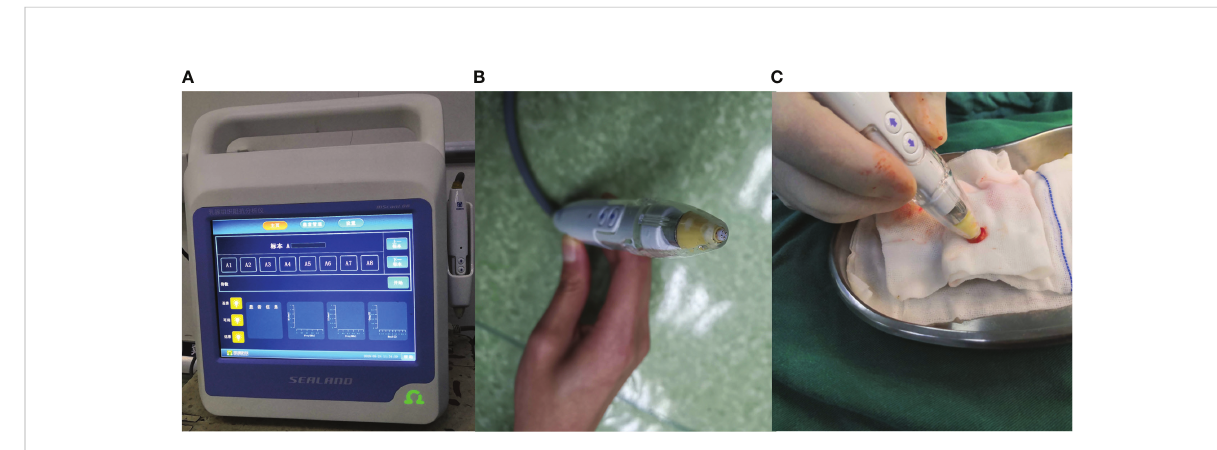
FIGURE 1 The Bioelectrical Impedance Spectroscopy analyzer. (A) analyzer. (B) probe. (C) the way of